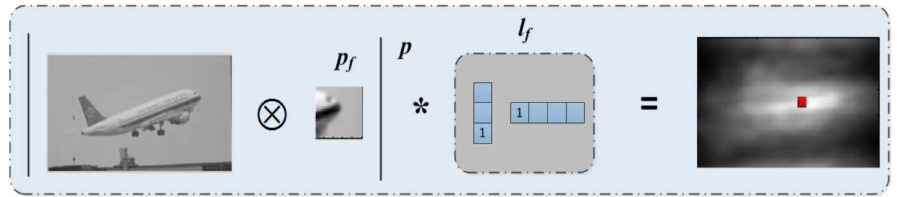
Figure 4. A local informative patch is employed to construct feature vectors, from the picture in right column, object area has higher response than backgrounds.